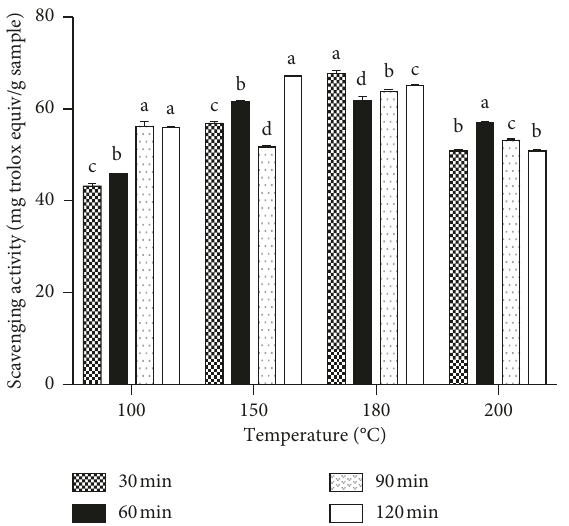
Figure 2: Effects of temperature and time on antioxidant activity (ABTS scavenging activity) of C. latifolia root extracts by SWE. Different letters indicate significant differences ( p < 0 . 05) within the same extraction temperature.